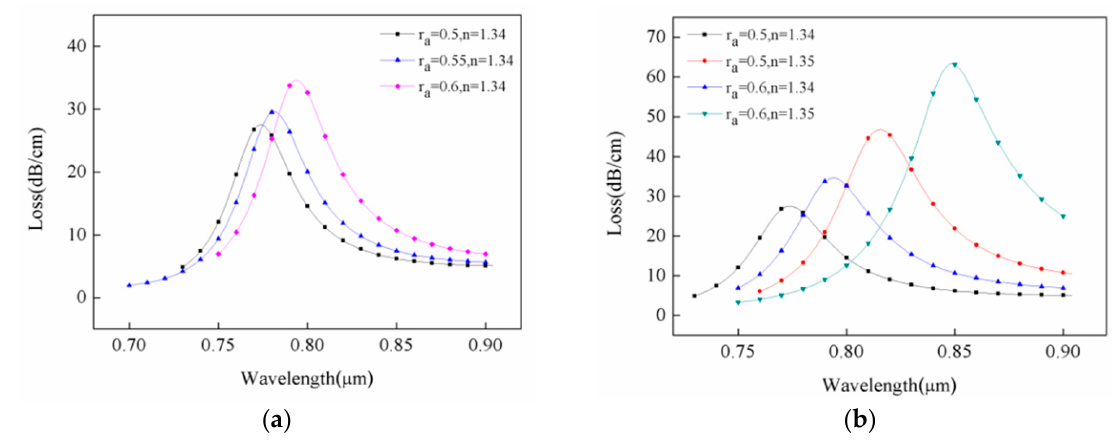
Figure 4. ( a ) Loss spectra of the same refractive index under different inner air hole radii. ( b ) Effects of changes in radius of inner air hole on resonance wavelength under different refractive indexes. Conditions: r b = 0.2 μ m and r g = 0.2 μ m.